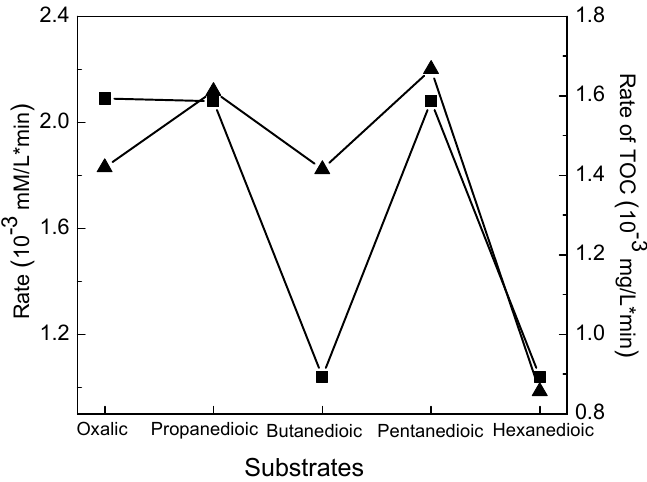
Figure 2. Average rates for both full conversion ( ■ ) and TOC removal ( ▲ ) by TiO2-based photocatalysis for the five dicarboxylic acids as a function of their carbon number